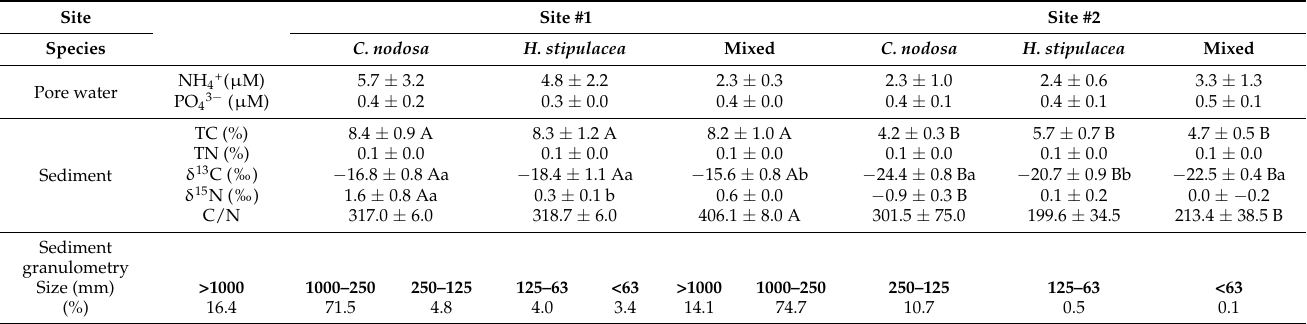
Table 2. Characterization of abiotic matrices (mean values ± standard deviation). Significant differences between the sites (two-way ANOVA Tukey’s post-hoc test) are indicated by capital letters, and in lowercase between meadow